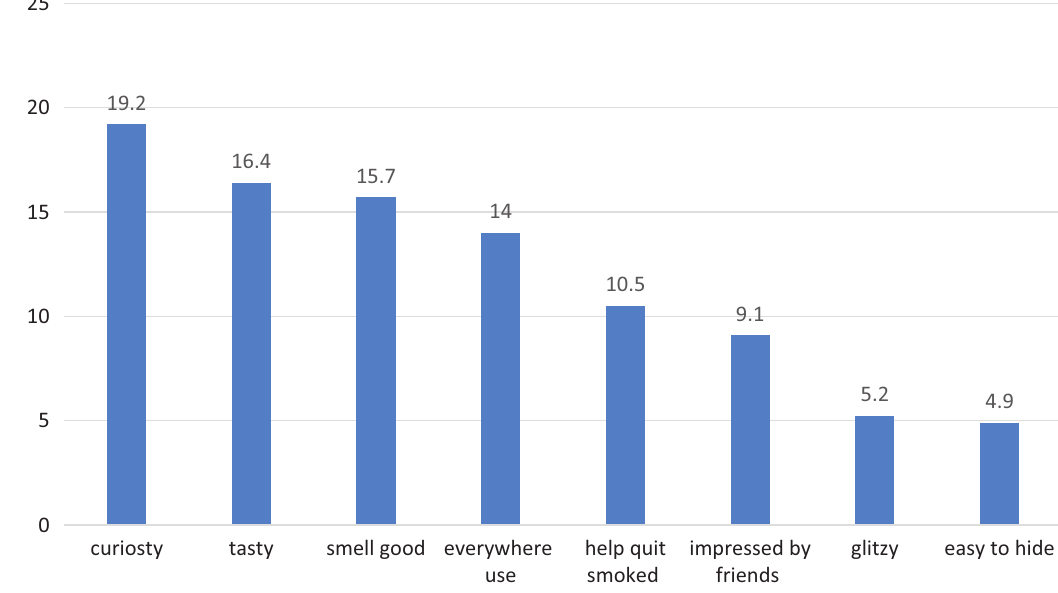
Figure 1. Reasons for participants’ e-cigarette